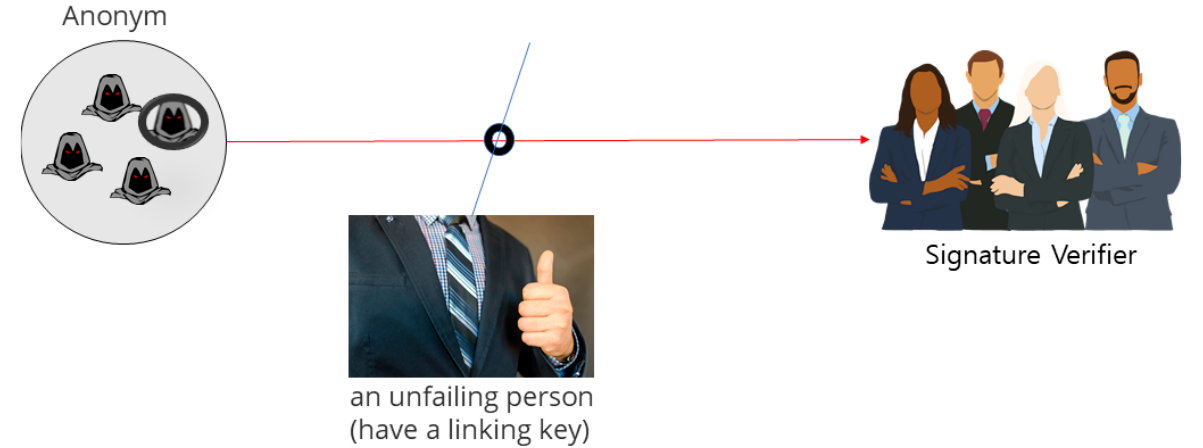
Figure 4. The group signature method.